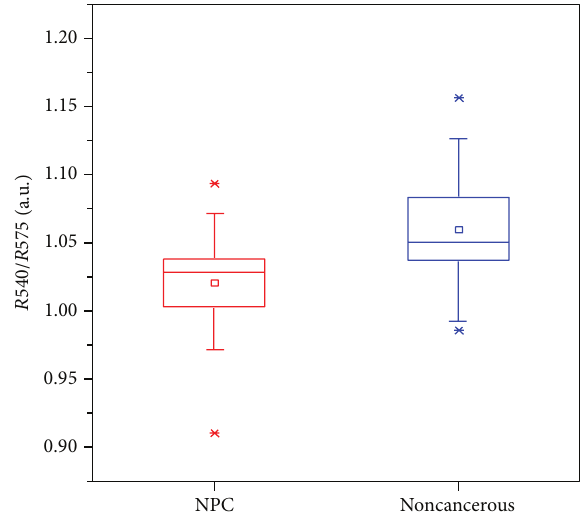
Figure 7: Mean reflectance ratios ( 𝑅 540/ 𝑅 576) of NPC (red box) versus those of noncancerous group (blue